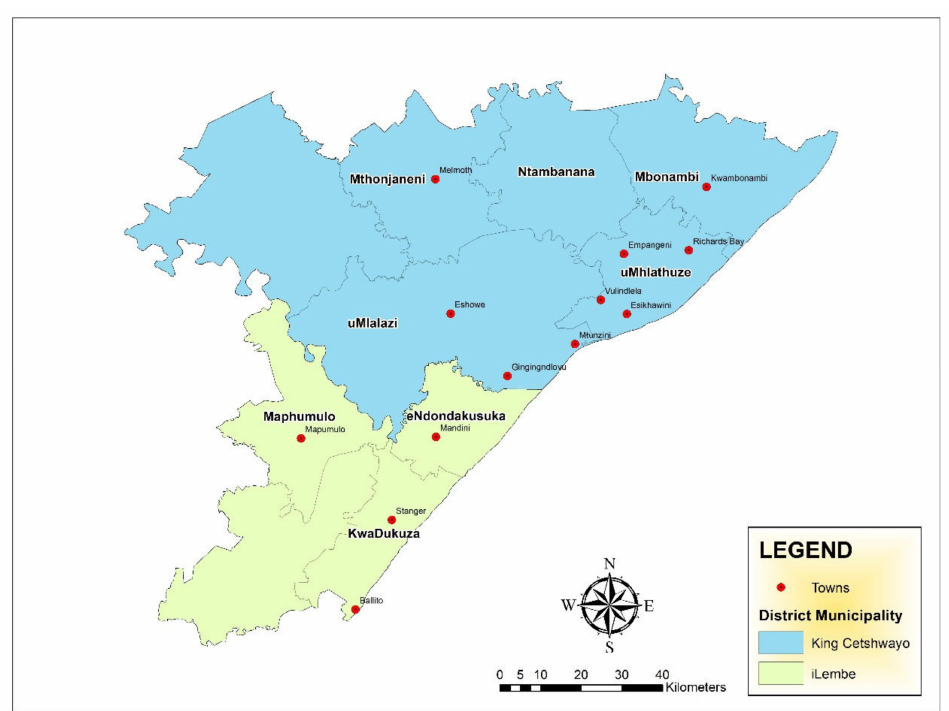
Figure 1. Map of King Cetshwayo district and iLembe district in KZN province, South Africa showing the towns were sample were obtained (Source: Naidoo,